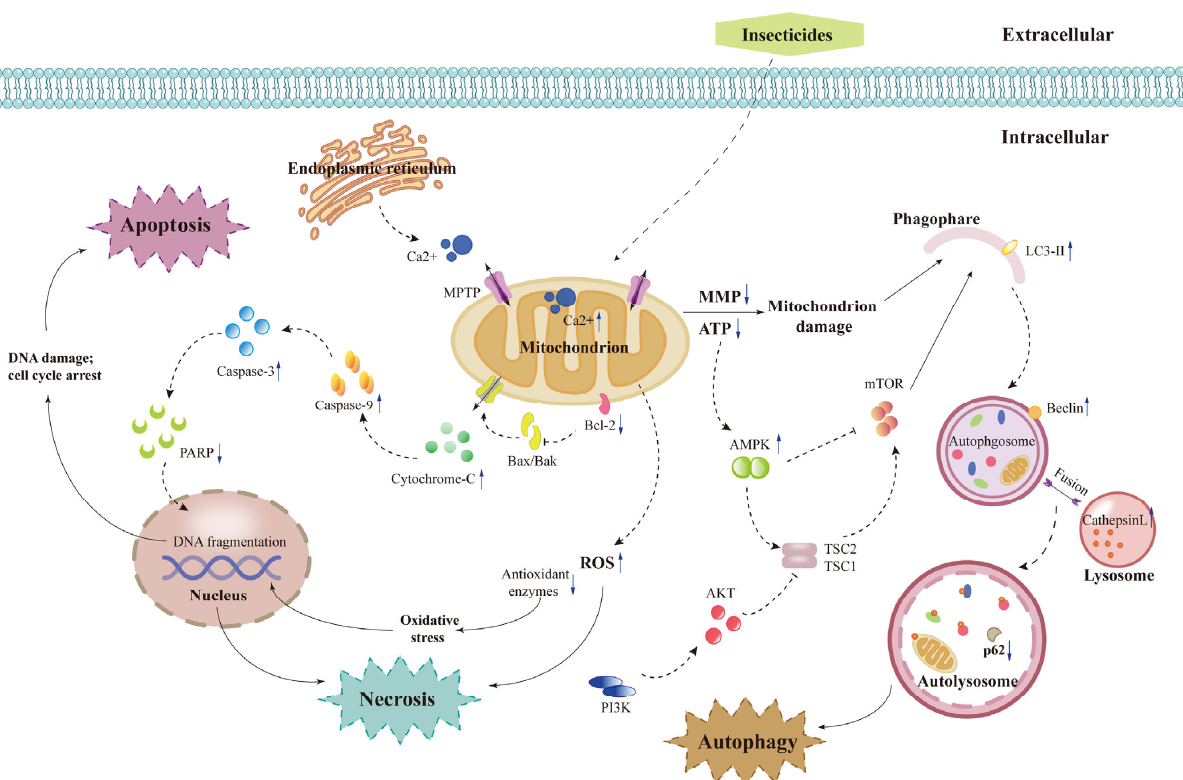
Figure 3. Potential cell death mode and signal pathway in insect cell lines after insecticide treatment. Insecticides could either induce apoptosis via the mitochondrial pathway, induce cell cycle arrest as a result of DNA damage, induce autophagy via the mTOR pathway or induce necrosis in insect cells. These actions of insecticides both interact with each other and work in coordination with inhibition of cell proliferation. Blue solid arrows pointing upwards or downwards represent increase or decrease in the respective substances. Black dotted arrows represent the possible routes, and black solid arrows represent the effect or action of insecticides.